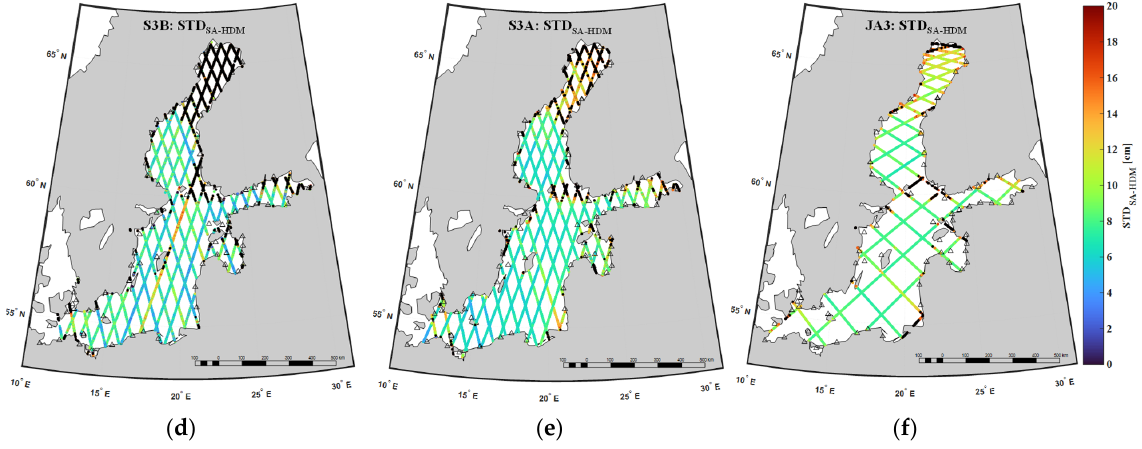
Figure 12. Statistics of the along-track SA examination. (top row) Mean ∆ DT SA − HDM , discrepancies between SA along-track DT data ( DT SA ) and DT HDM − corr ( MEAN SA − HDM ) during 2017–2019 for ( a ) S3B, ( b ) S3A and ( c ) JA3 missions (Equation (10)). The | ∆ DT SA − HDM | > 20 cm are represented as black dots in the MEAN SA − HDM plots and this is excluded from the calculation of the RMSE value of the whole basin per each mission (Equations (12) and (14)). In addition, (bottom row; ( d – f )) associated STDs of ∆ DT SA − HDM (Equation (11)) larger than 20 cm are denoted in black